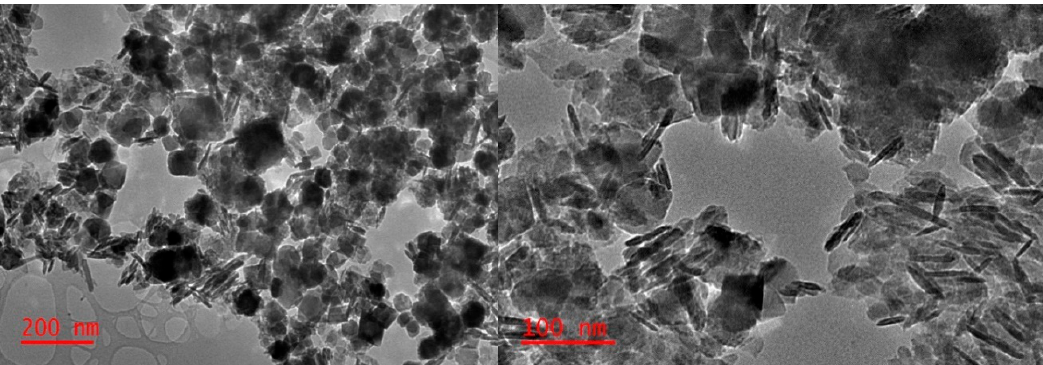
Figure 4. Exemplary TEM images of the synthesized akaganeite nanomaterial in absence of any surfactant.